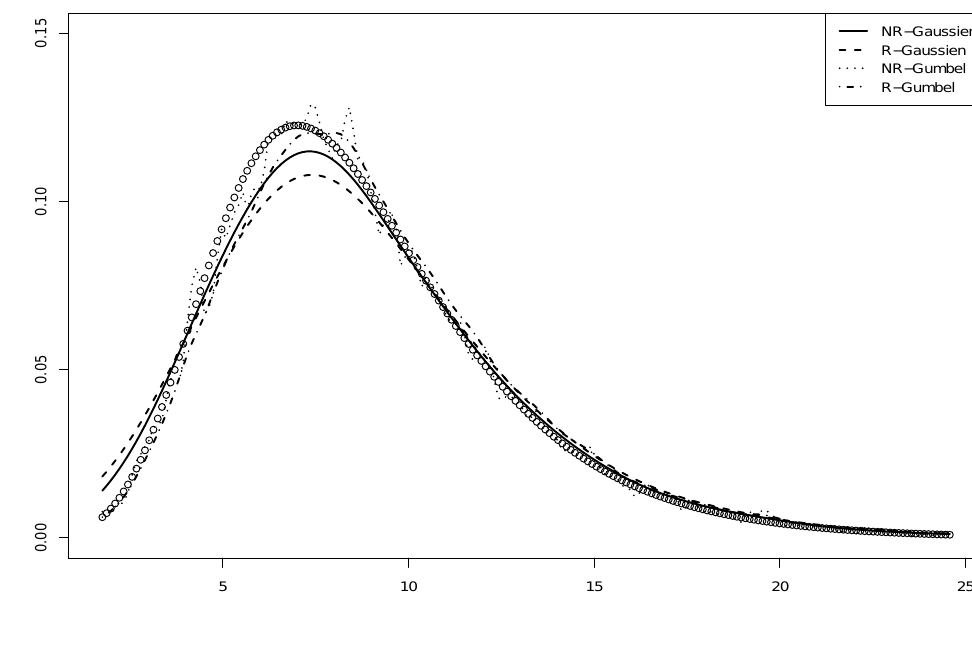
Figure 1: Qualitative comparison between the four considered estimators. The circles represent the true distribution. Here we consider the Gumbel distribution G um (7, 3) and the sample size n = 200 .